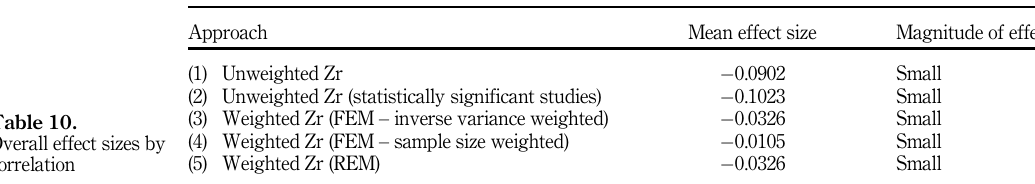
Table 10. Overall effect sizes by